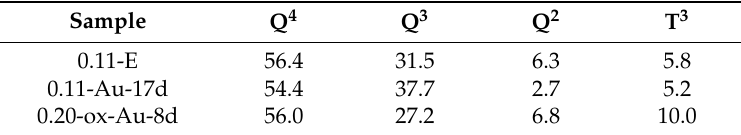
Table 3. Population of Si species (%) as determined by 29 Si MAS NMR.